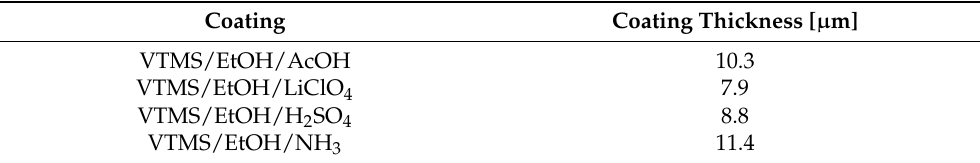
Table 5. Thickness measurement results for individual coatings on steel X20Cr13.